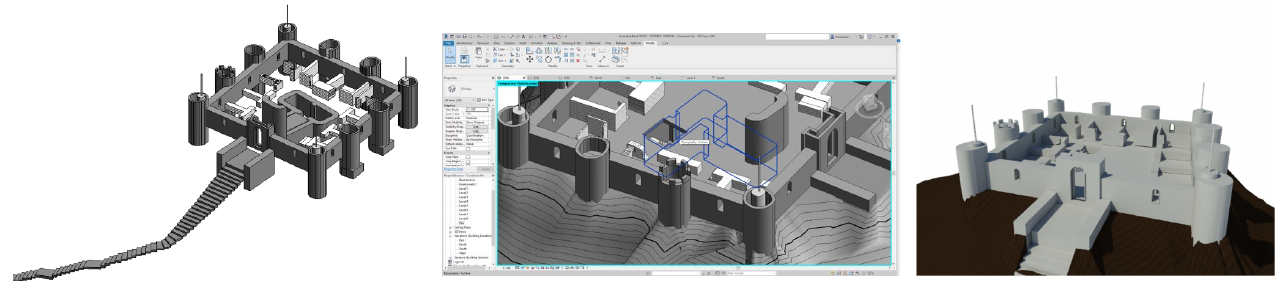
Figure 23. The granular model of the Asfan